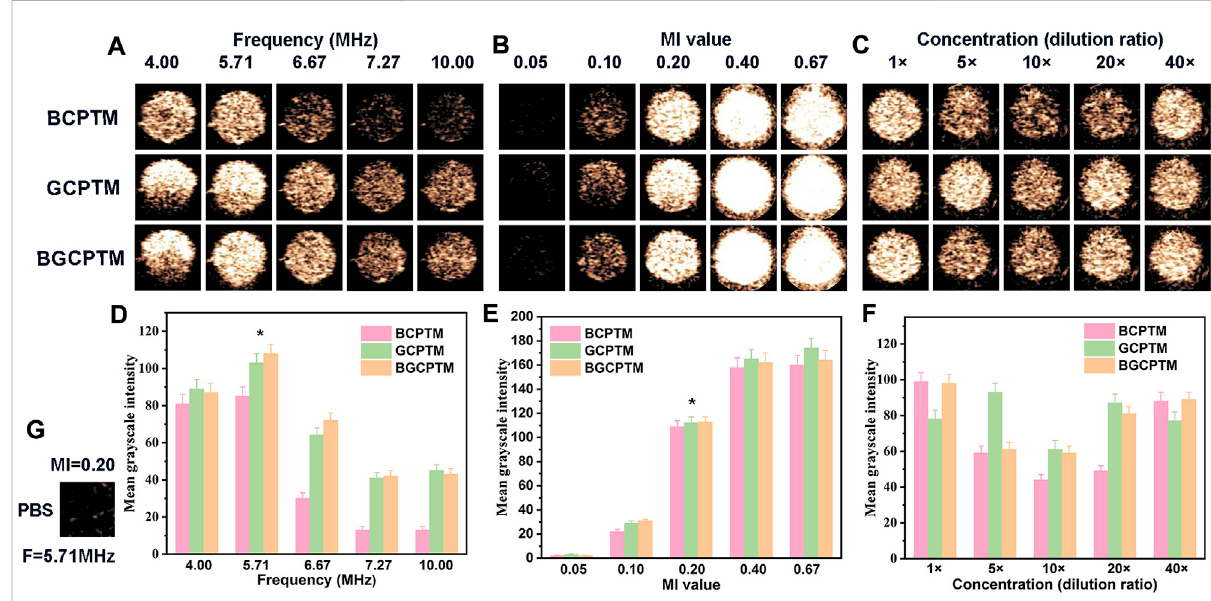
FIGURE 4 InVitro UltrasoundImaging. (A) CEUSimagesofBCPTM,GCPTM andBGCPTMunderdifferentfrequencies invitro . (B) CEUS imagesofBCPTM, GCPTM and BGCPTM under different MI. (C) CEUS images of BCPTM, GCPTM and BGCPTM under different concentration. (D) MGI of CEUS images under different frequencies. (E) MGI of CEUS images under different MI. (F) MGI of CEUS images under different concentration. (G) As control, the CEUS image of PBS was obtained at 5.71 MHz frequency and 0.20 MI, and no enhancement was detected in this